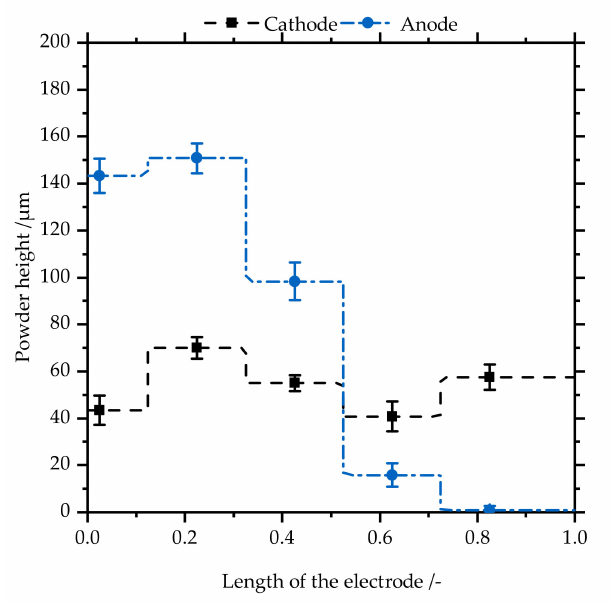
Figure 4. Powder height along the cathode and the anode. Powder height is approximately constant on the cathode, but mostly separates over the first half of the